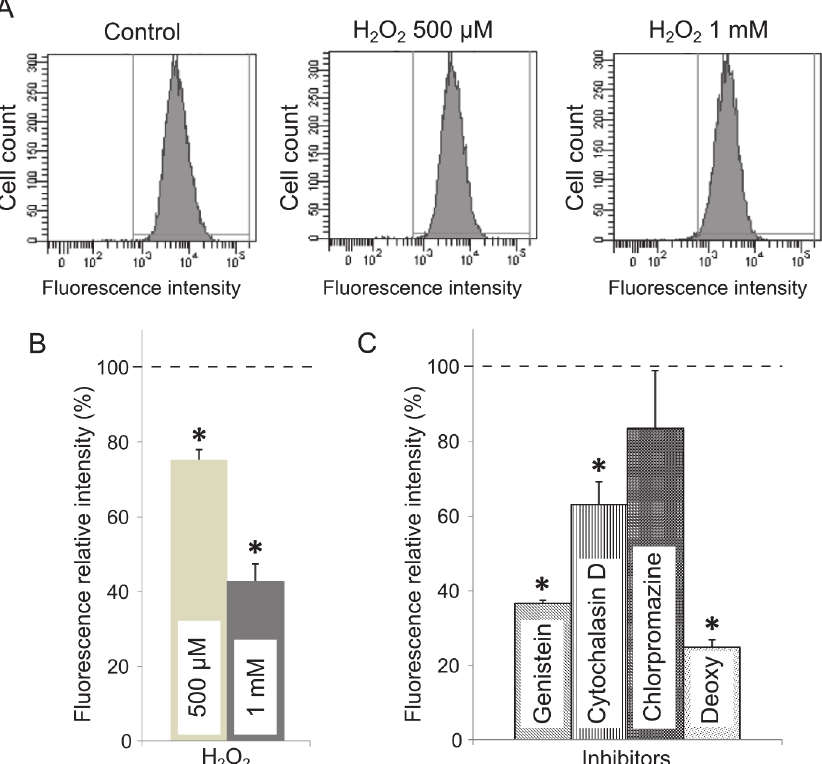
Fig 5. Effect of H 2 O 2 on caveolae-dependent endocytosis. Cells were incubated with 0.25 μ M of Bodipy- lactosylceramide after treatments with H 2 O 2 or specific inhibitors of endocytic pathways as described in materials and methods. Cells were analyzed by flow cytometry ( λ exc = 488 nm) including at least 10 000 cells by condition (A). The mean cellular fluorescence intensity was expressed as a percentage of the fluorescence measured in the untreated control cells ( — -) (B and C). Bars on the graph represent the SEM. * Significantly different from the control sample ( P < 0.01).